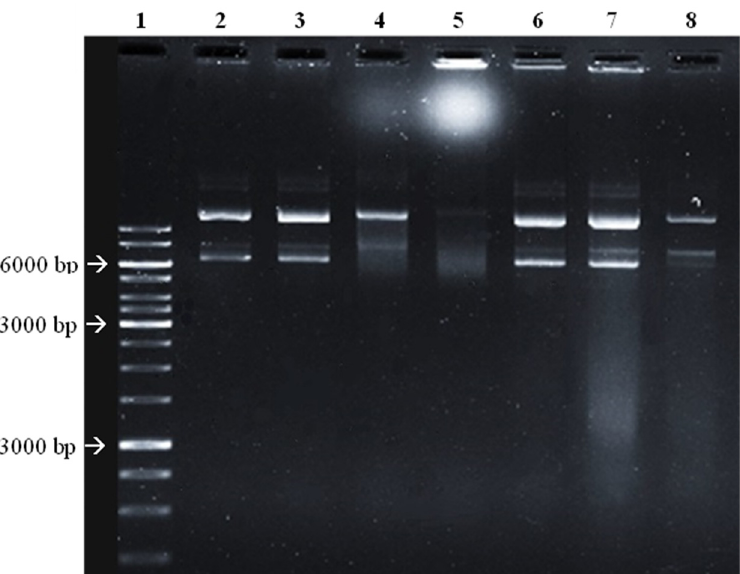
Figure 6. Electrophoresis gel. 1—Marker; 2—DNA; 3—negative control (DMSO); 4—10 μ g/mL ciprofloxacin; 5—30 μ g/mL ciprofloxacin; 6—negative control (DMSO); 7—F2 (water insoluble) fraction (1 mg/mL); 8—F3 (diethyl ether) fraction (1 mg/mL). Agarose at 0.8%, ran at 85 V for 1 h. Image was obtained through gel imaging system (Gel doc). This figure is representative of